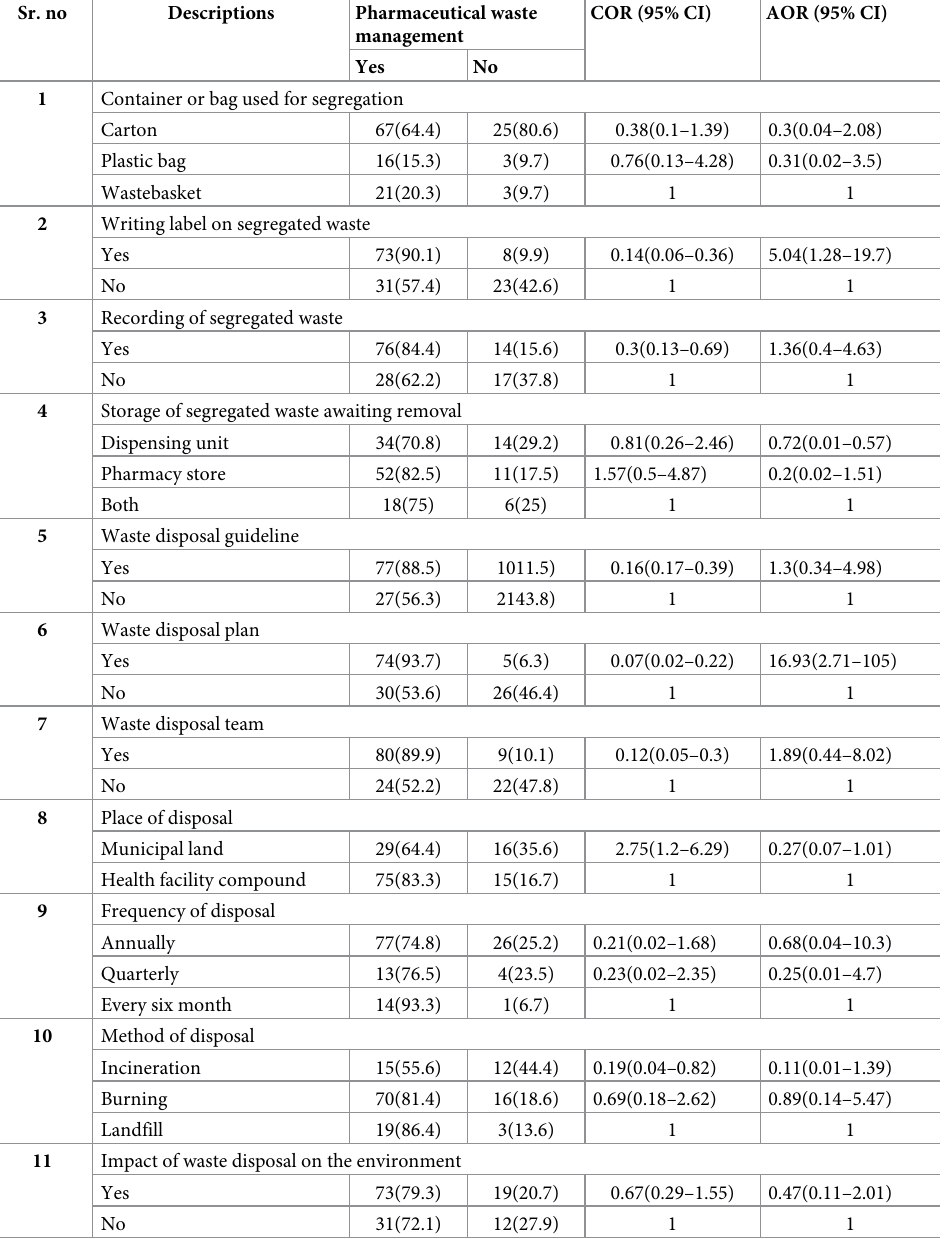
Table 7. Factors associated with pharmaceutical waste management in public health facilities of Dessie town, Ethiopia. Sr.